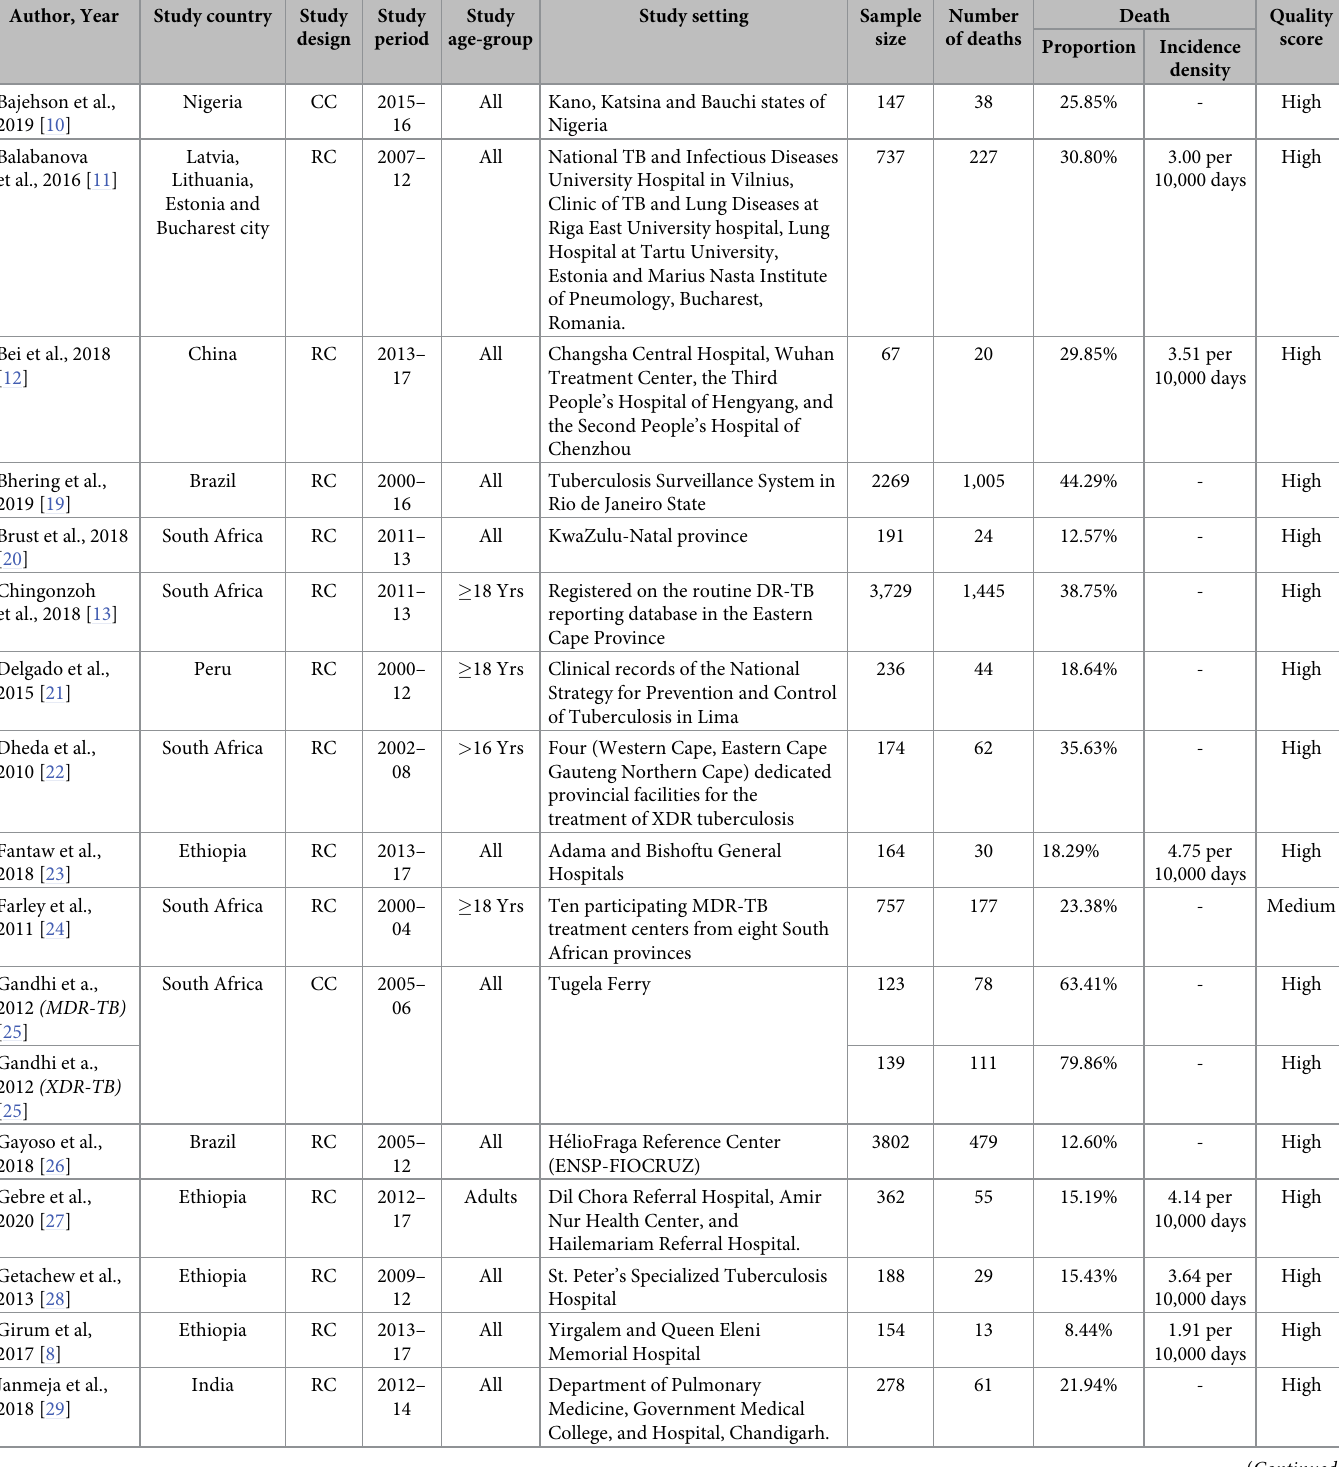
Table 1. Characteristics of individual studies on the predictors of mortality in patients with drug-resistant tuberculosis, included in the current systematic review and